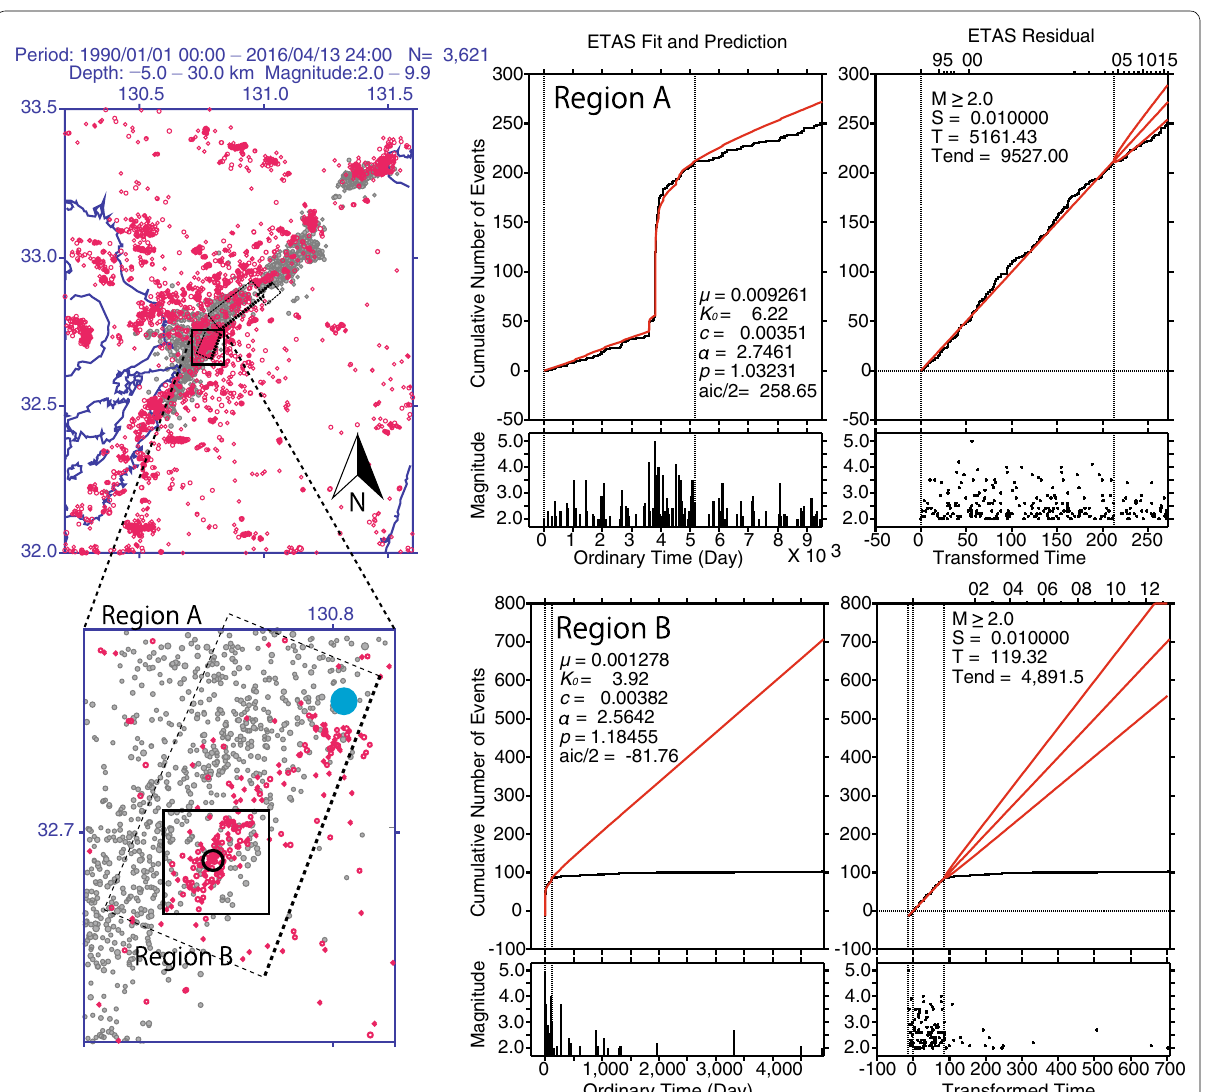
Fig. 4 ETAS model fittings to the restricted regions. ETAS model (1) is fitted to the seismicity in Region A, including the narrow aftershock Region B of the 2000 M5.0 earthquake, beneath which the aftershocks of the 2016 M6.5 and M7.3 Kumamoto earthquakes are plotted as gray circles. The red circles indicate earthquakes from January 1, 1990, until the M6.5 Kumamoto earthquake on April 14, 2016 (blue disk), and its aftershocks prior to the M7.3 mainshock, with a threshold magnitude of M c 2.0, are plotted as gray circles. The dashed rectangles indicate the fault models of the 2016 = Kumamoto earthquakes listed in Table 3. The seismicity in Region B is from 09:32, June 8, 2000, when the mainshock of M5.0 (marked by a thick circle) occurred, and consists only of its aftershocks. The right panels show the ETAS model fitted before the change-point MLE (dashed vertical line) for Region A (top panels) and for the narrower Region B (bottom panels). The estimated cumulative curves are superimposed (red curves) on the observed values (black curves) versus the ordinary time (the left side of each pair) and the transformed time (the right side of each pair). The cor- responding M–T plots are attached under the corresponding panels